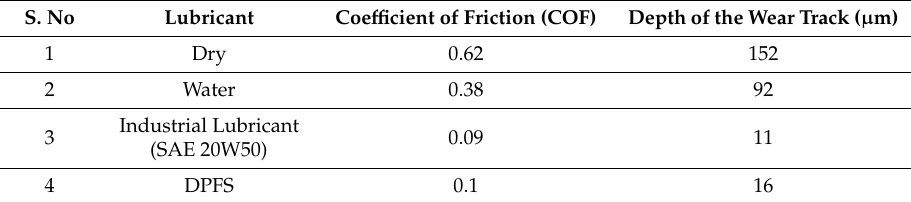
Table 1. Summary of the results obtained by Samad